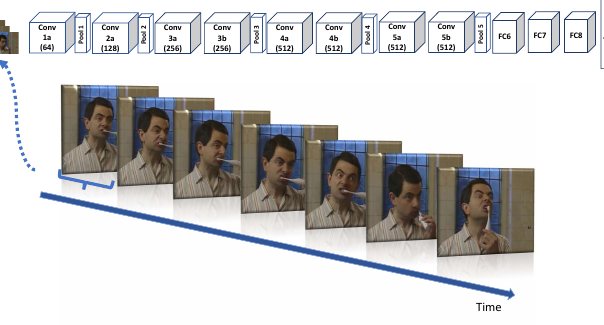
Figure 6. This figure illustrates the OAD-3D-CNN model that is used to monitor patients’ daily living activities. The AI model is fed with the video stream captured by the camera installed on the LOLA platform. In particular, clips of 16 contiguous video frames are passed to the model. Eight 3D convolutions are included in the deep learning architecture, followed by five max-pooling layers and three fully connected layers. A final softmax layer is responsible for producing the classification of the action for every video clip.